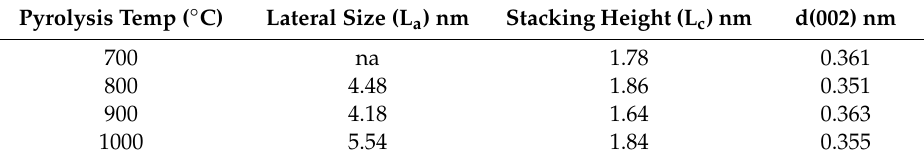
Table 1. Structural parameters calculated from XRD patterns of the C1-TS sample prepared using pTS